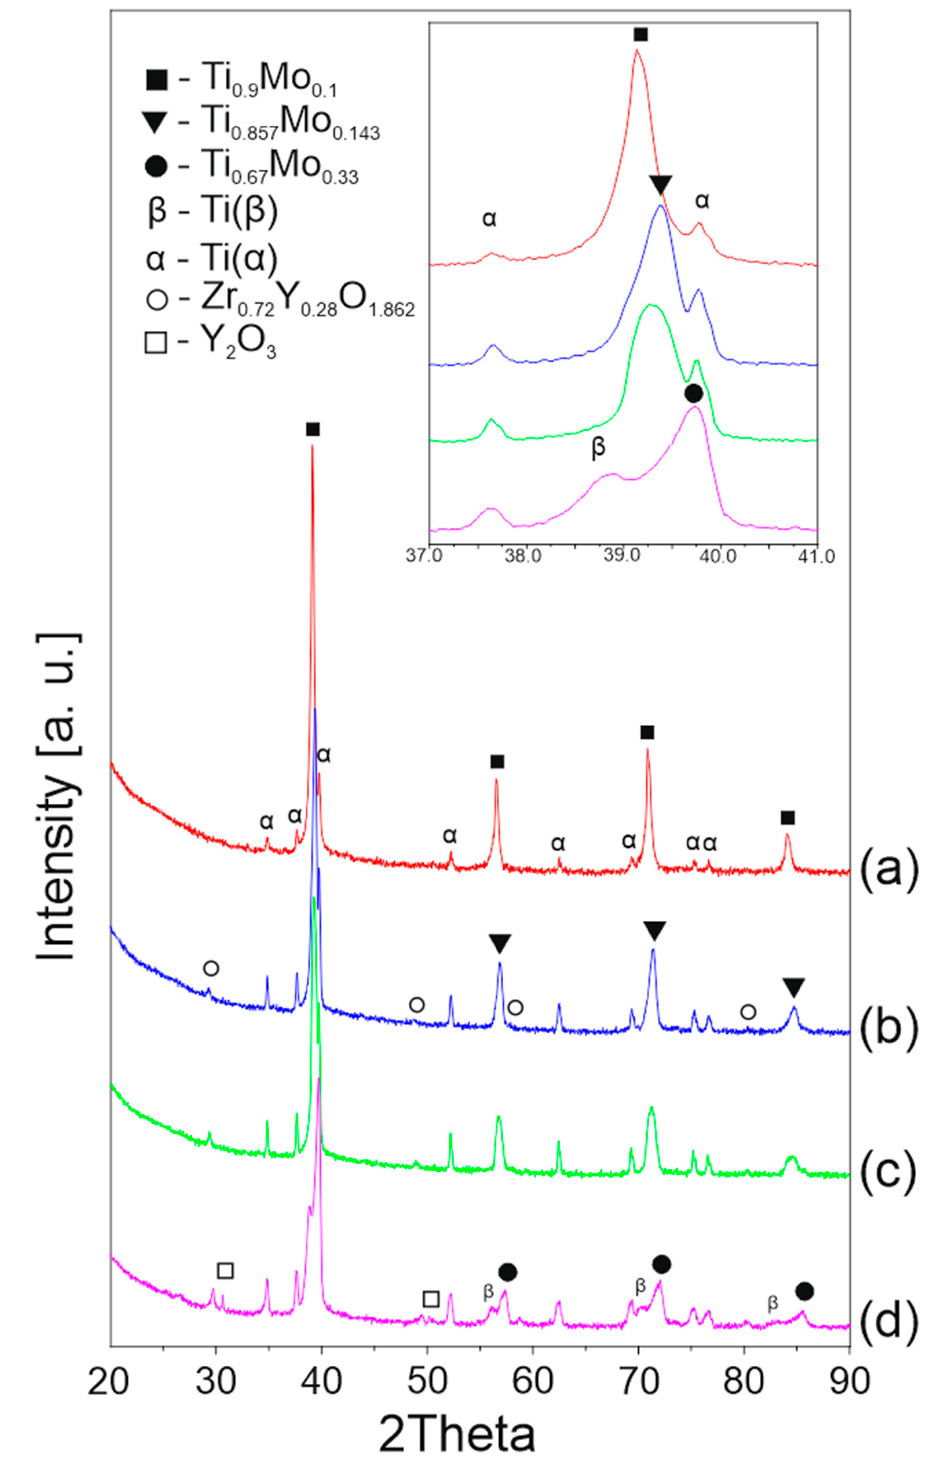
Figure 6. XRD patterns of 27 ( a ), 27–3 ( b ), 27–5 ( c ), 27–10 ( d ) after sintering.